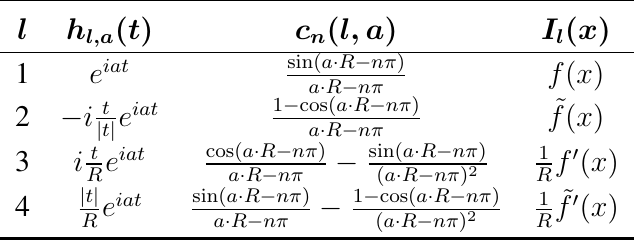
( t ) = h ( t ) e iat in [ − R, R ] , and I l,a l